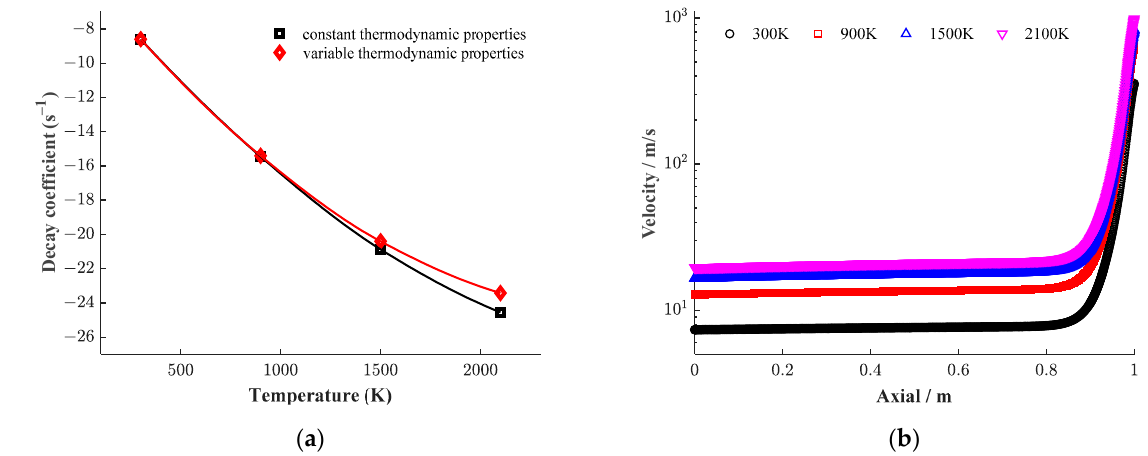
Figure 14. The decay coefficient and the axial velocity of motor under different gas temperature. ( a ) The decay coefficient under different working temperatures. ( b ) The axial velocity of motor under different gas temperatures.